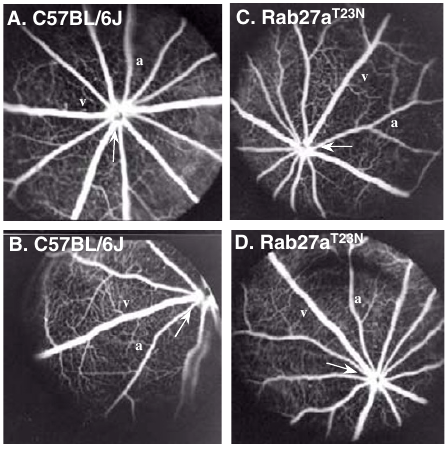
Figure 8 Fluorescein fundus angiograms of Rab27a T23N transgenic mouse retina. Angiograms of six monthsold wild-type (C57BL/6J littermate control) (A and B) or Rab27a T23N transgenic mouse (A27aT25/2 line) (C and D) taken one minute after dye injection were obtained as described under "Methods". The venules (v) are twice the diameter of the arterioles (a). The arrow denotes the optical